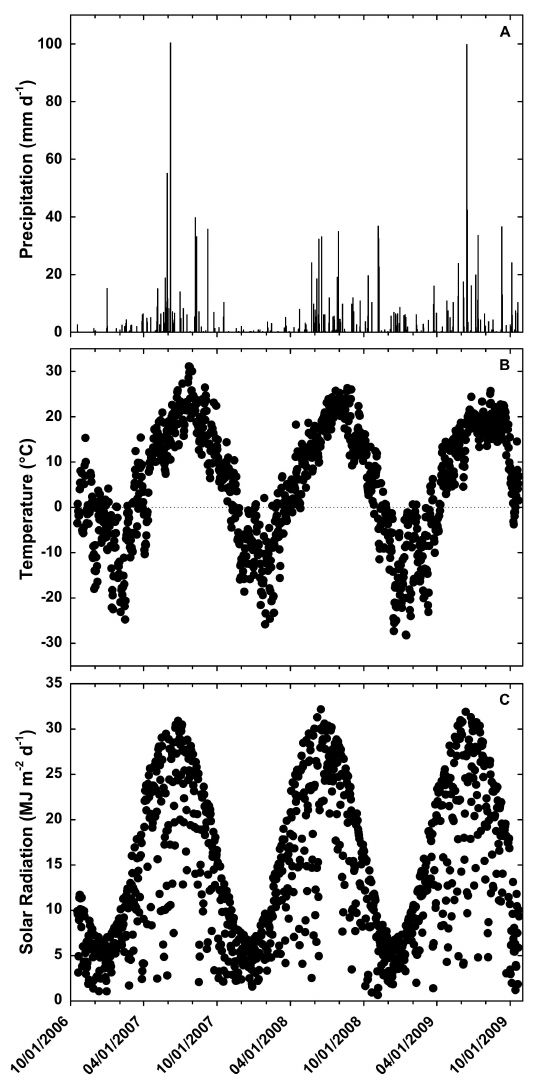
Figure 1. Daily precipitation ( A ), daily mean air temperature ( B ) and daily total solar radiation ( C ) 2